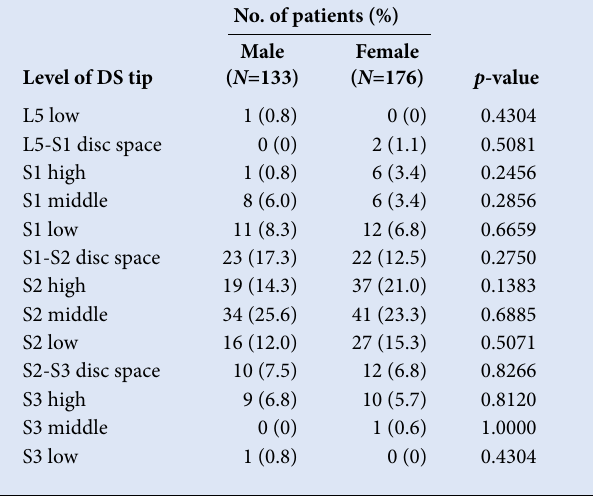
Fig. 2. Distribution of different levels of the dural sac tip as determined by means of a T2-weighted MRI of the lumbar spine.